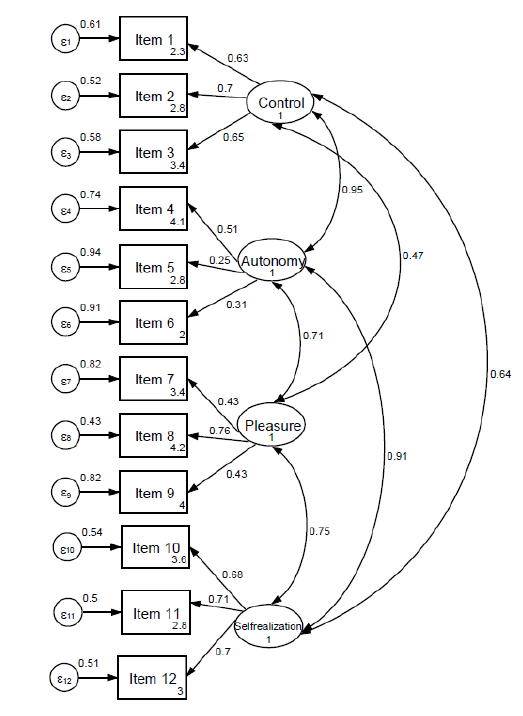
Figure 1. Path diagram of the CASP-12 model. Root mean squared error of approximation (RMSEA) = 0.07; comparative fit index (CFI) = 0.90 ( χ 2 = 444.59; df = 48; p < 0.001). The diagram shows standardized values of loadings and error variance.